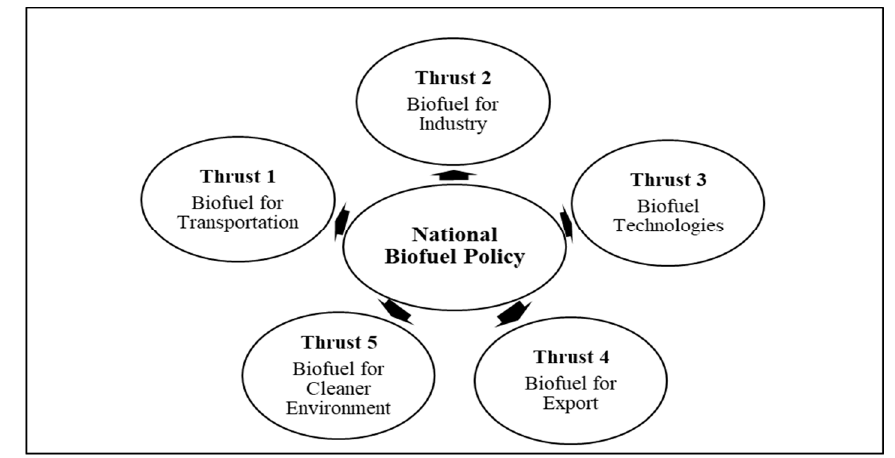
Figure 5. Five strategic thrusts under Malaysian National Biofuel Policy.